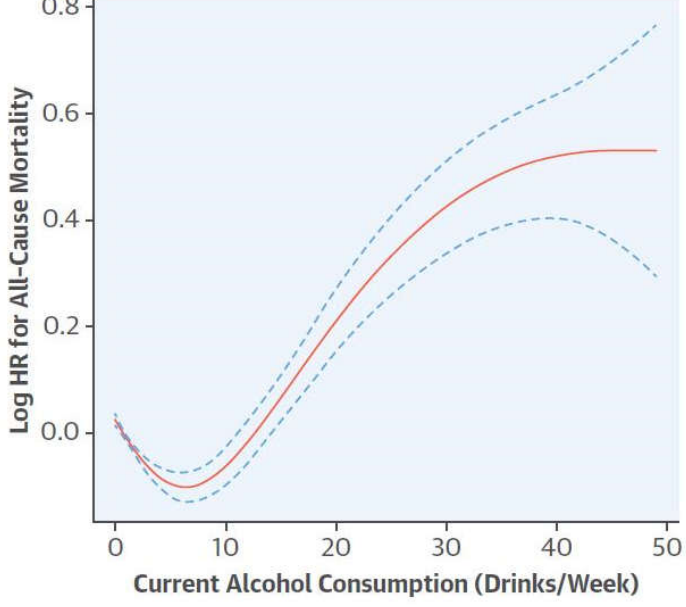
Figure 10. The new J curve [107].